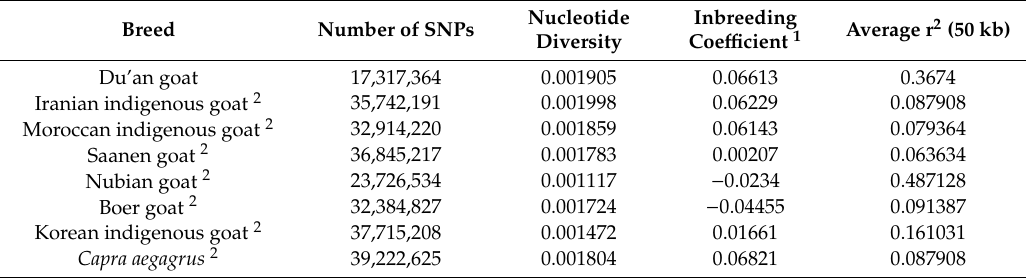
Table 2. Di ff erence in genomic characteristics between the Du’an goat and seven other goat breeds.